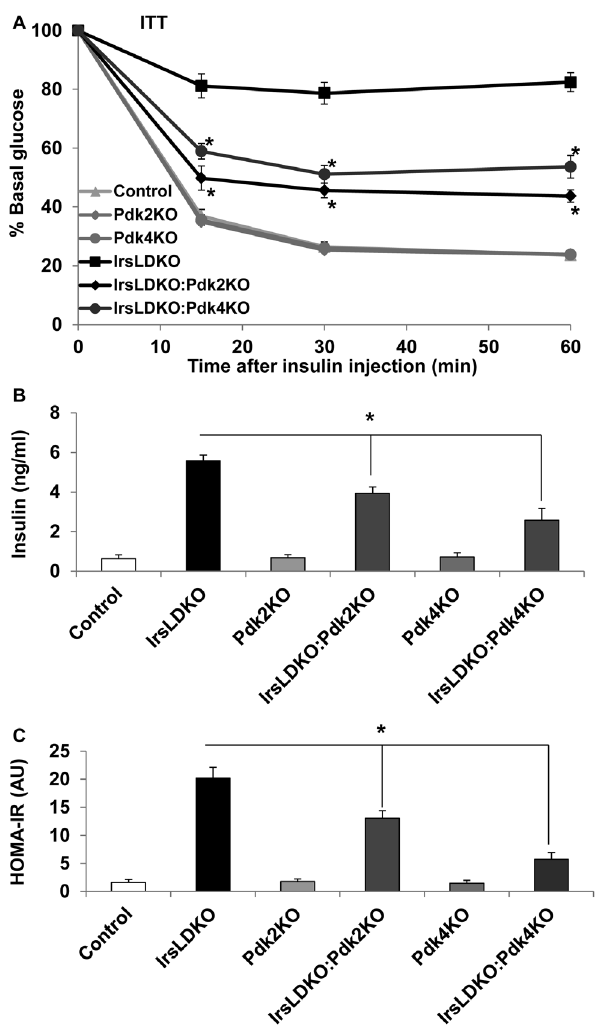
Figure 4. Inactivation of Pdks improves insulin sensitivity in IrsLDKO mice. A, Insulin tolerance tests (ITT) were performed in age- matched control and knockout mice (n=8–20). B, Fasting plasma insulin was analyzed in age-matched control and knockout mice (n=5– 9). C, HOMA-IR (homeostatic model assessment-insulin resistance) was analyzed using fasting glucose and insulin data. Data are presented as means 6 SEM. *, P , 0.05 relative to corresponding controls.